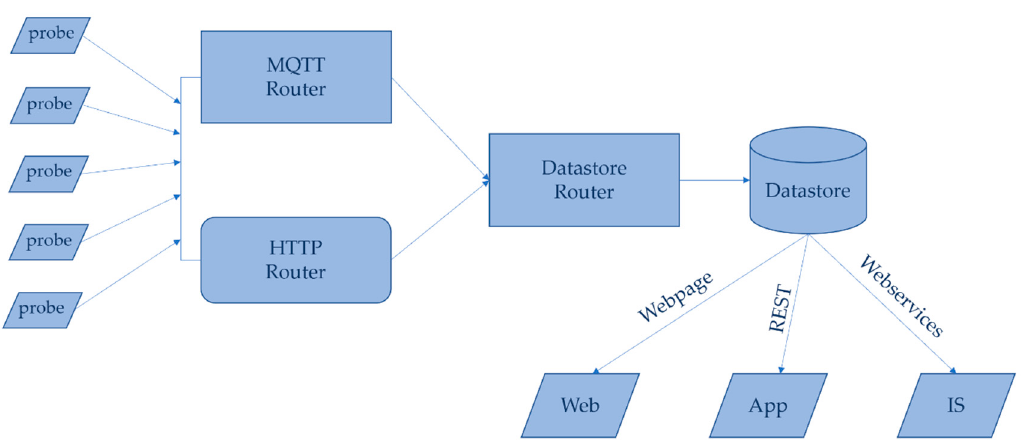
Figure 7. Network architecture of the platform showing flow of measurements and data through the routing layers to end users via web pages, web apps and associated integrative stores (IS).